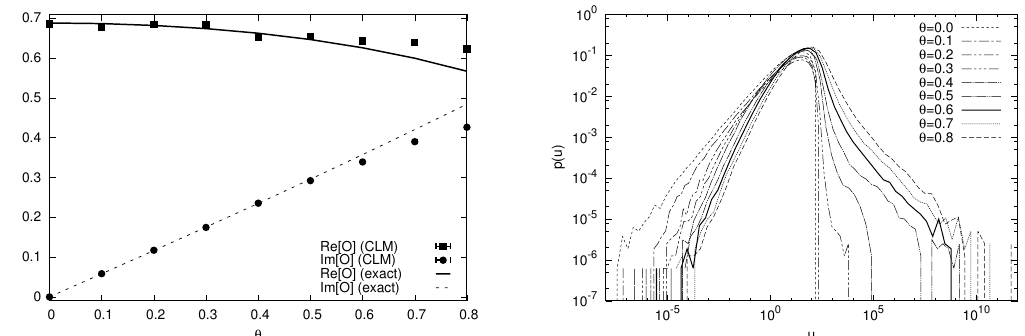
Figure 1 . (Left) The real and imaginary parts of the expectation value of the average plaquette obtained by the CLM are plotted against (cid:18) . The solid and dotted lines represent the exact results obtained by the character expansion. (Right) The probability distribution (3.11) of the drift term is shown in log-log plots for various (cid:18)